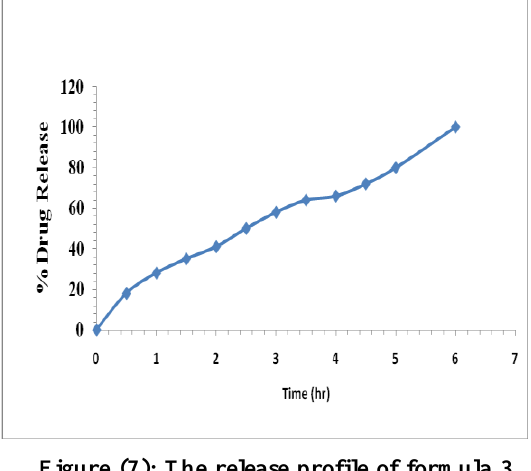
Figure (7): The release profile of formula 3 in simulated tear fluids at 37 0 C .